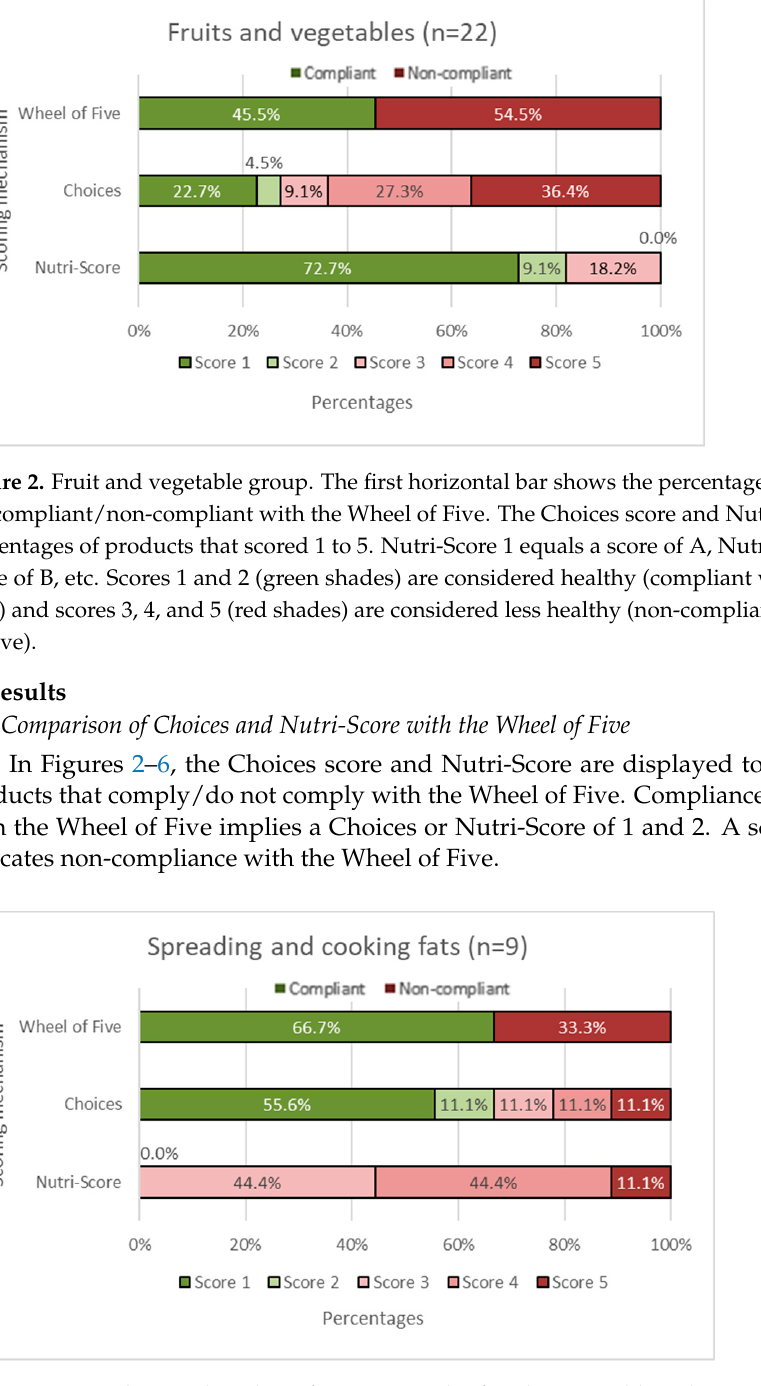
Figure 4. Dairy, nuts, fish, legumes, meat, and eggs group. The first horizontal bar shows the per- centages of products that are compliant/non-compliant with the Wheel of Five. The Choices score and Nutri-Score show the percentages of products that scored 1 to 5. Nutri-Score 1 equals a score of A, Nutri-Score 2 equals a score of B, etc. Scores 1 and 2 (green shades) are considered healthy (com- pliant with the Wheel of Five) and scores 3, 4, and 5 (red shades) are considered less healthy (non- compliant with the Wheel of Five).